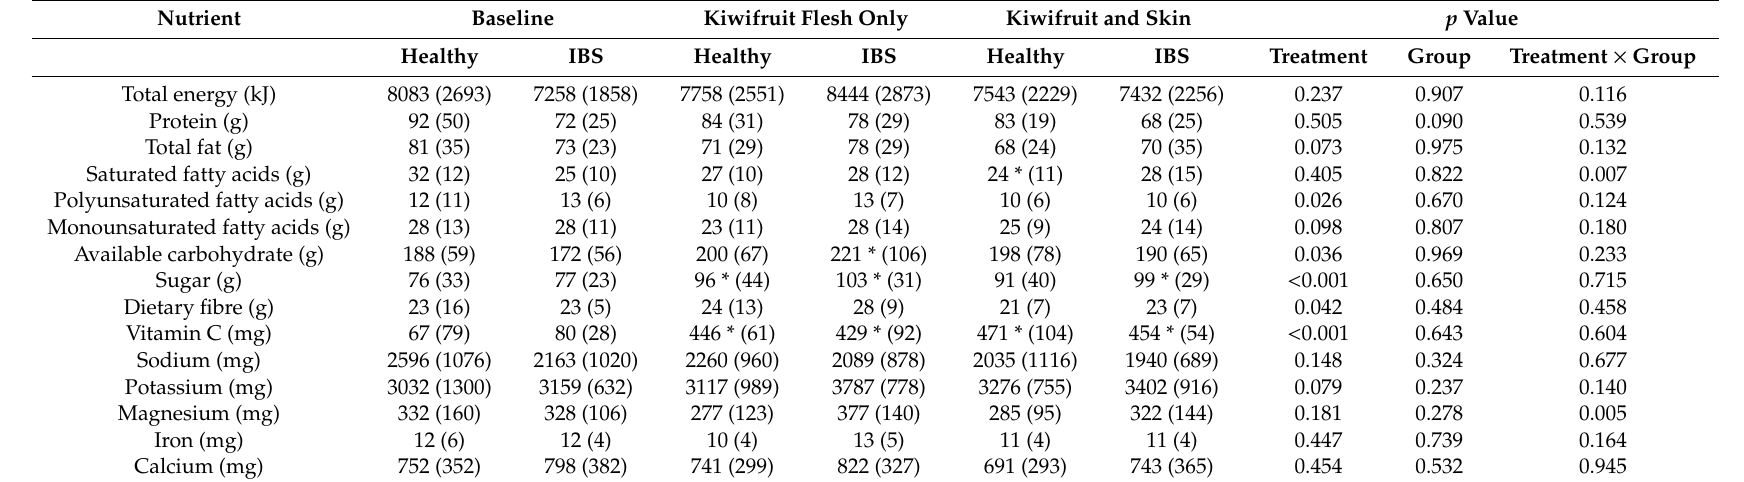
Table 9. Daily dietary intakes of selected nutrients by the participants including the Zespri ® SunGold kiwifruit ( Actinidia chinensis var. chinensis ‘Zesy002’)